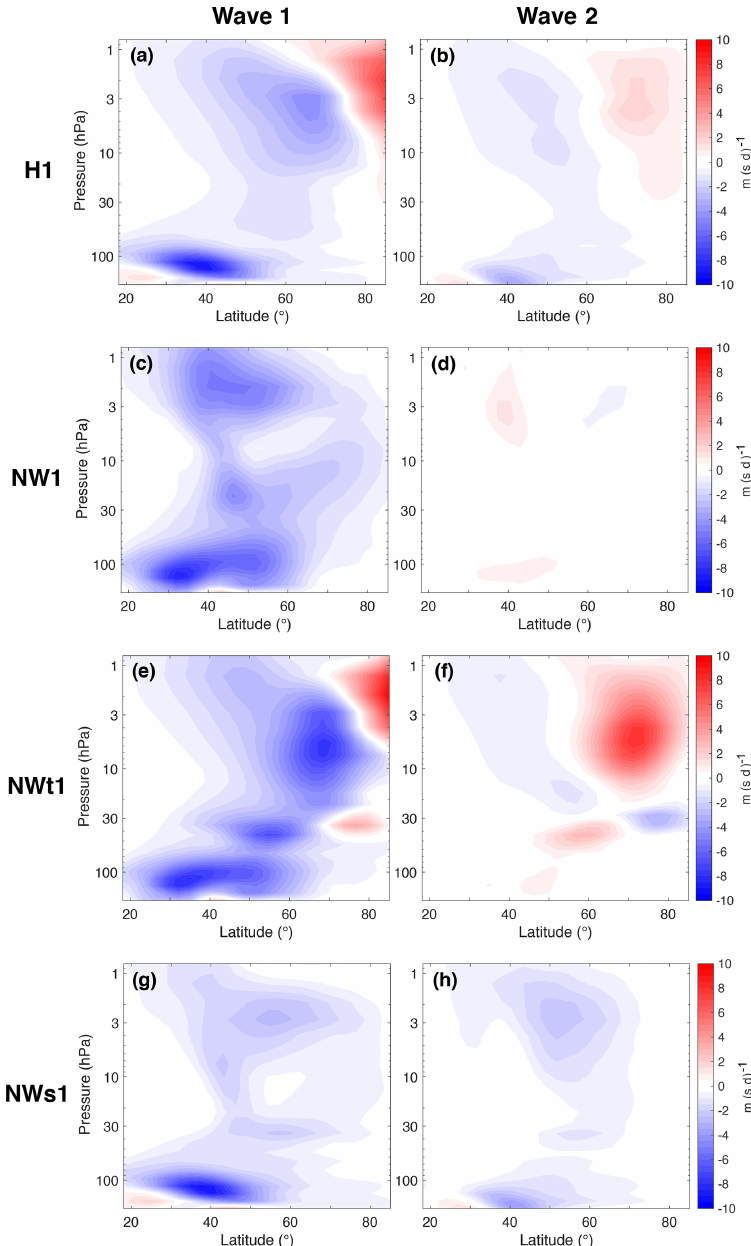
Figure 3. Divergence of EP flux for H1 (a, b) , NW1 (c, d) , NWt1 (e, f) and NWs1 (g, h) . (a, c, e, g) Wave 1 components. (b, d, f, h) Wave 2 components. The contour interval is 0.5m ( sd ) − 1